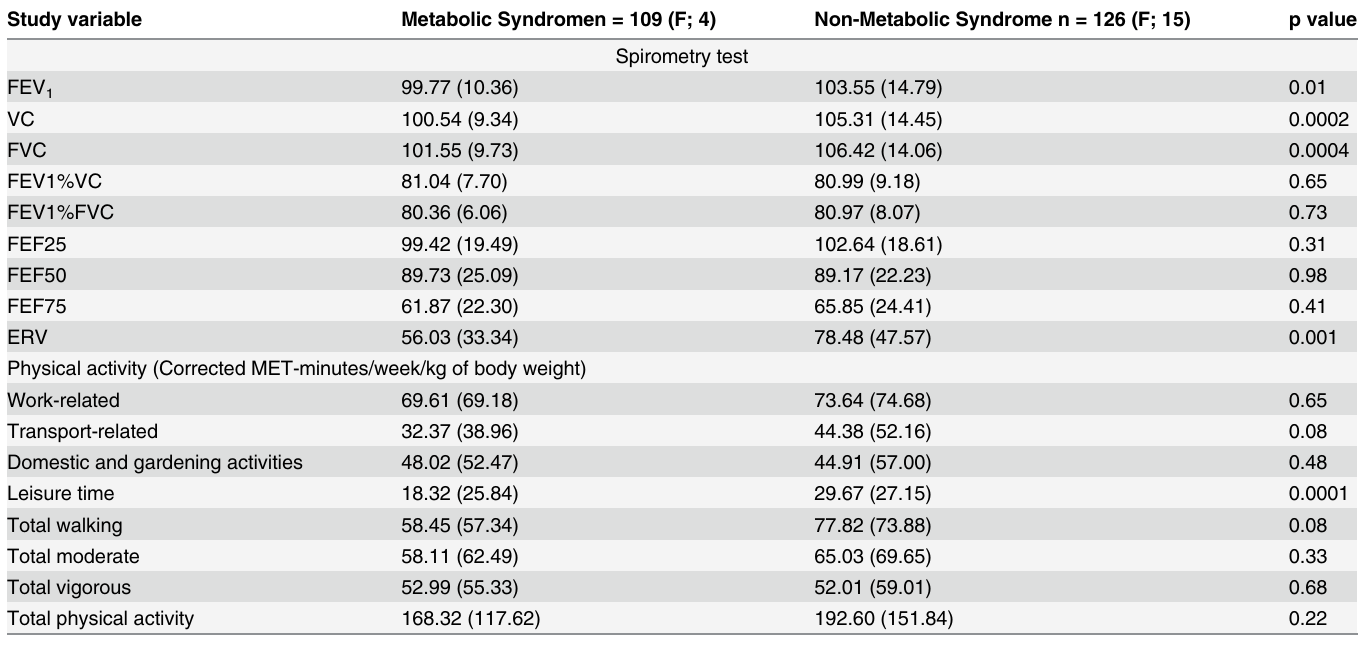
Table 6. Spirometry test results and the intensity of physical activity in the study subjects stratified by metabolic syndrome status. Study